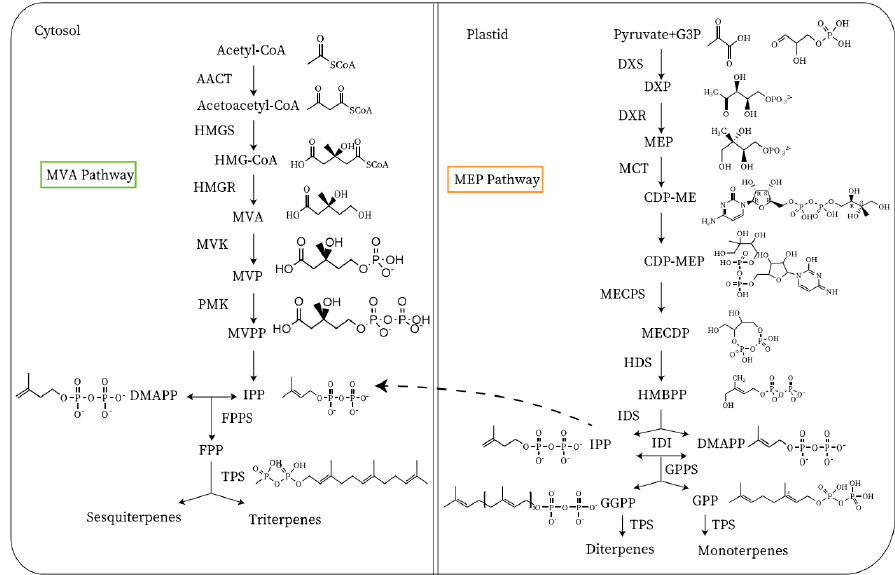
Figure 2. Synthesis of terpenoid volatile organic compounds. AACT, acetyl-CoA acetyltransferase; HMG-CoA, hydroxymethylglutaryl-CoA; HMGS, HMG-CoA synthase; HMGR, hydroxymethyl- glutaryl-CoA; MVA, mevalonic acid; MVK, mevalonate kinase; MVP, mevalonate 5-phosphate;